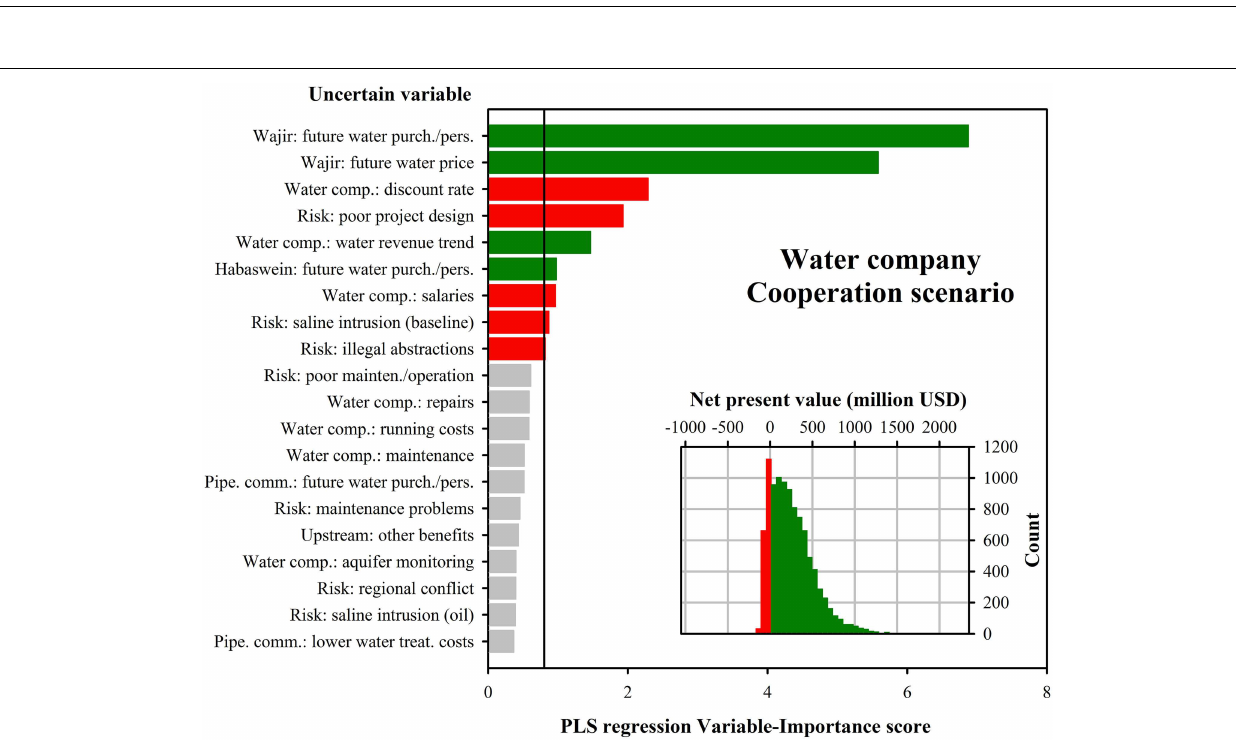
FIGURE 9 | Key sources of uncertainty in projecting outcomes for the water company for the “cooperation” scenario, as identified by Partial Least Squares (PLS) regression. For a details description of the plots, see legend to Figure 5 .